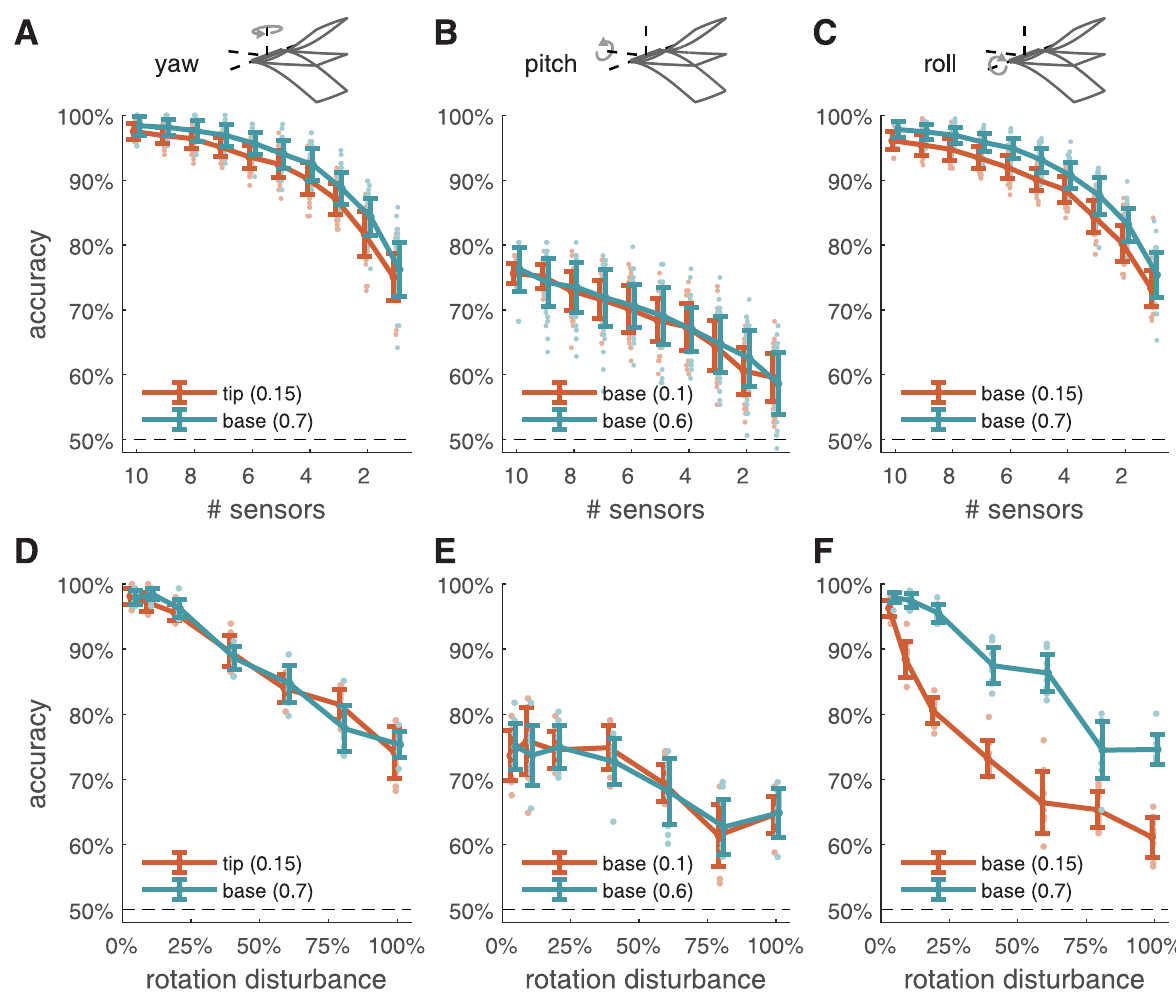
Fig 5. Robustness to sensor dropout and external disturbance. A: Accuracy of detecting rotation in the yaw axis as a function of number of sensors for two different wing stiffness/neural threshold parameter combinations (orange and teal). One parameter combination results in sensors at the wing tip, and a second results in sensors at the wing base, both with accuracy of 98% for 10 sensors. B–C: Same as A, for pitch and roll, respectively. In each case, two different parameter combinations were again chosen that produce similar accuracy with differing neural thresholds. For pitch-axis and roll-axis rotation detection, all sensors are located at the wing base. D–F: Accuracy as a function of the standard deviation of rotation disturbance for yaw, pitch, and roll, respectively, shown as the percentage of the constant rotation velocity to be detected. Parameter combinations same as corresponding A–C panels. Error bars in all panels denote ± 1 standard